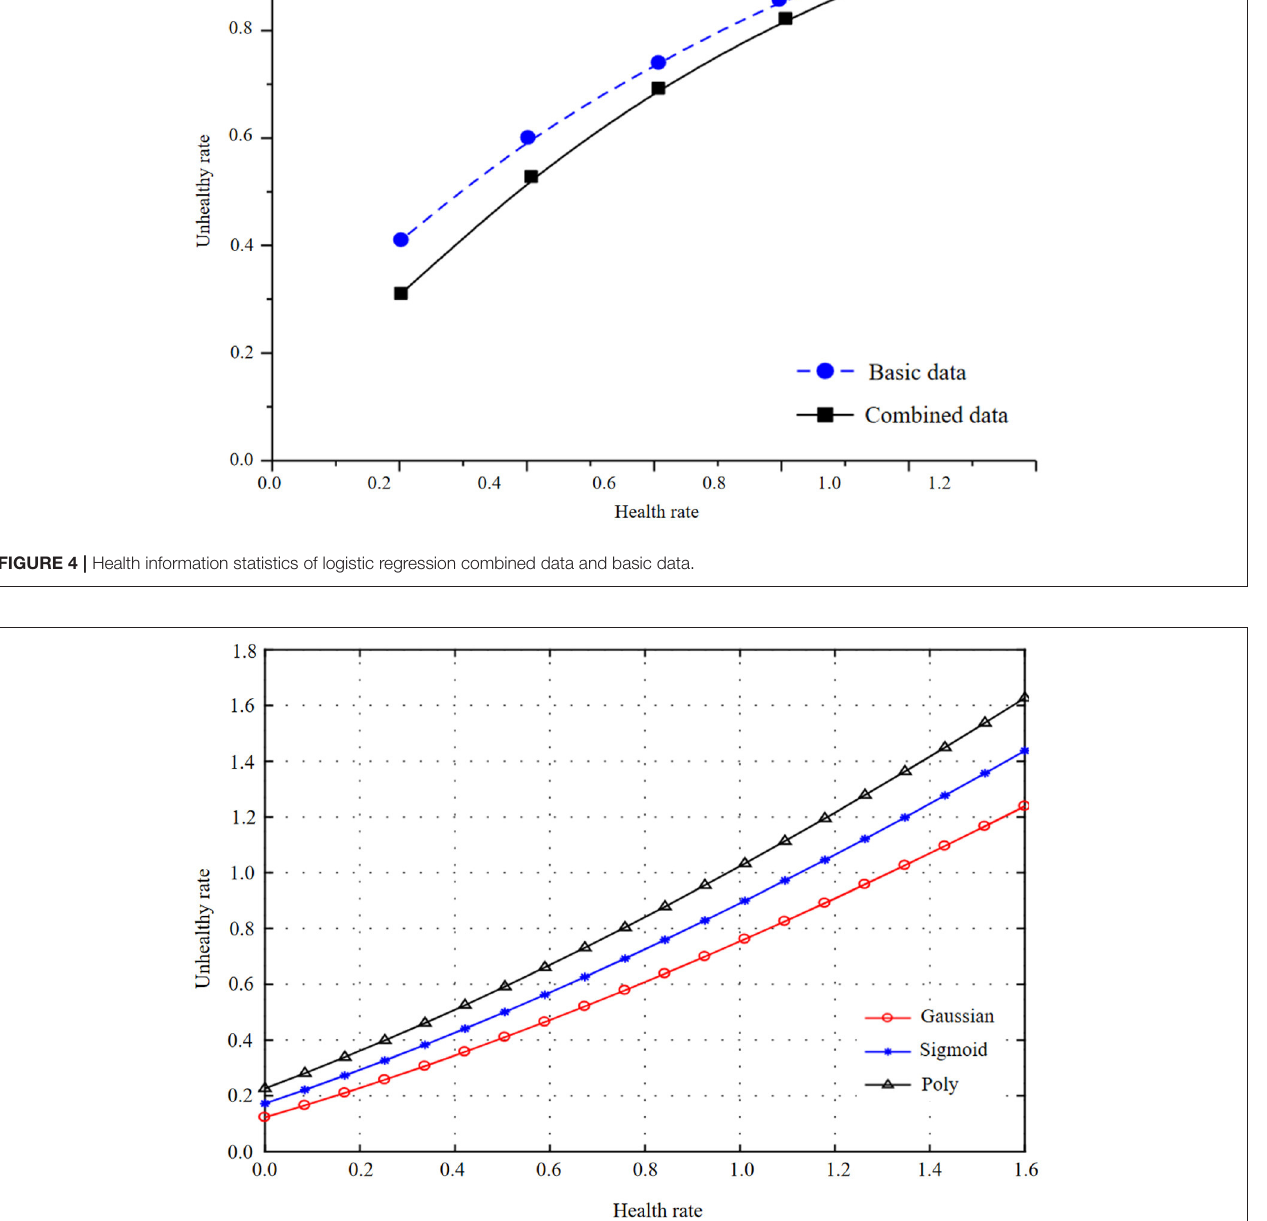
FIGURE 5 | Curve representations of three kernel functions of machine learning basic data and health information